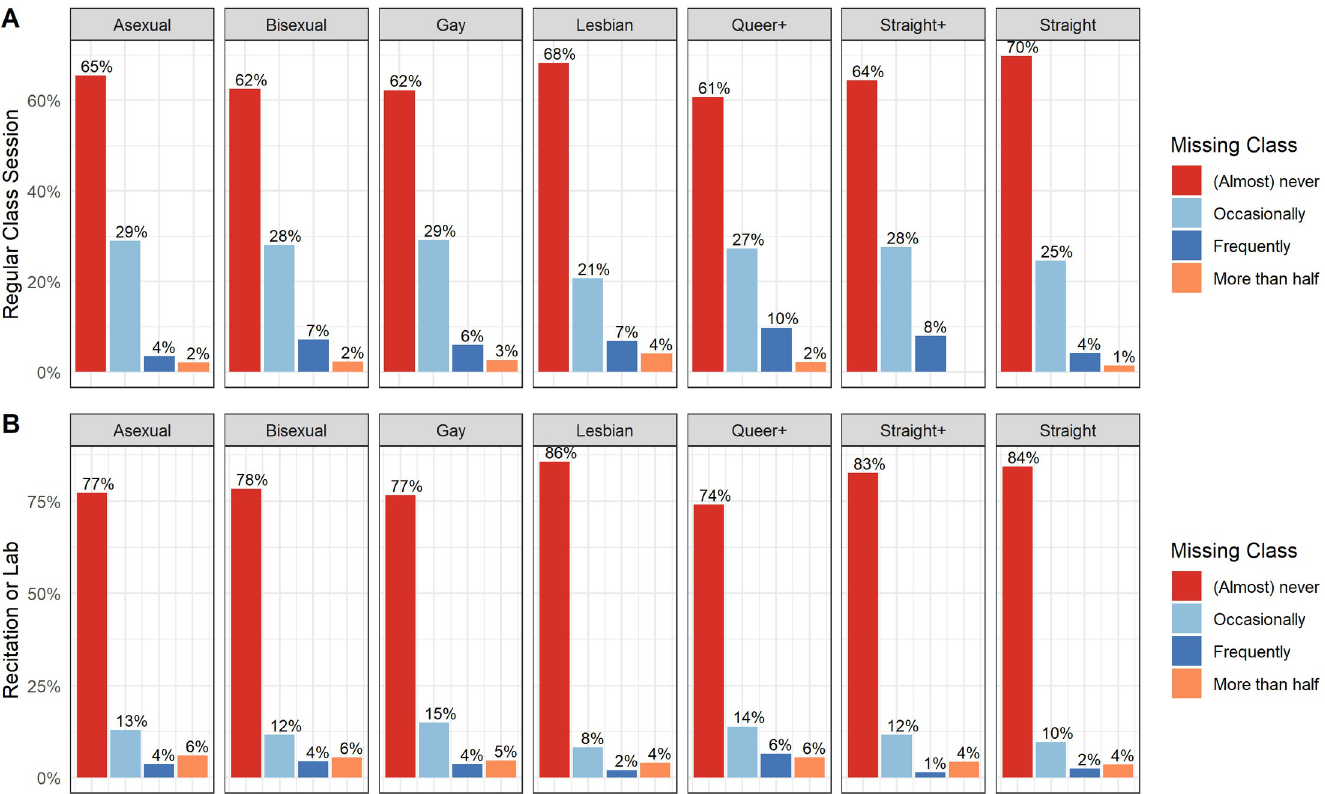
Fig 2. Histogram of course attendance in both Regular class and Breakout/Recitation across sexual identities.